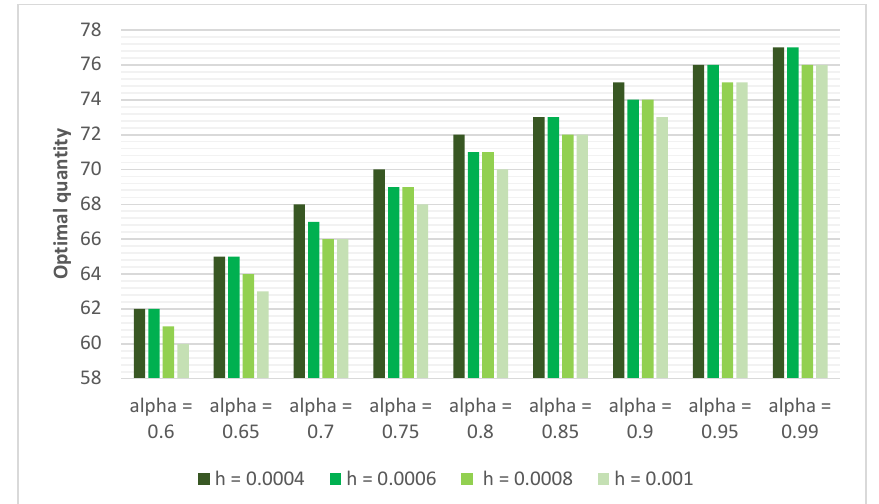
Fig. 6. Optimal quantity, double demand with stockholding costs